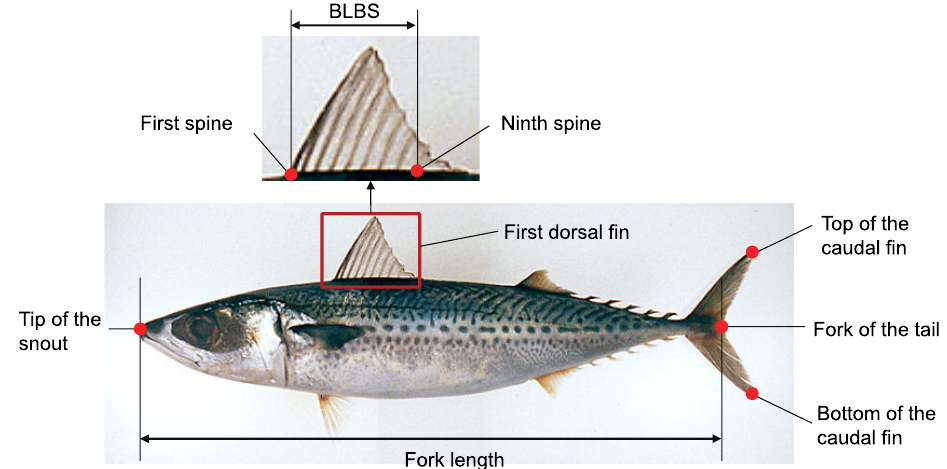
Figure 3. The base length between the first and ninth spines of the first dorsal fin (BLBS) and the fork